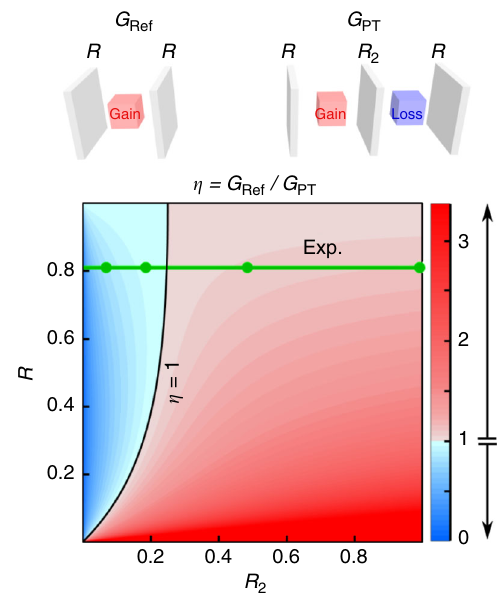
Fig. 2 Comparison of the thresholds from a PT-symmetric cavity and a reference cavity. The threshold-reduction factor η ¼ G Ref = G PT , where G Ref and G PT are the lasing thresholds for the reference gain-only cavity and the PT-symmetric cavity con fi gurations, respectively, shown schematically at the top. We plot η with R and R 2 , and two colour palettes are used to distinguish the regime of PT-enhanced threshold where introducing the gain-balancing loss reduces the lasing threshold with respect to that of the reference gain-only cavity ( η > 1, red palette), and PT-diminished threshold ( η < 1, blue palette), delineated by a black curve ( η = 1). The horizontal green line corresponds to the experimental value R = 0.82, and the circles to the experimental values of R 2 (see Table